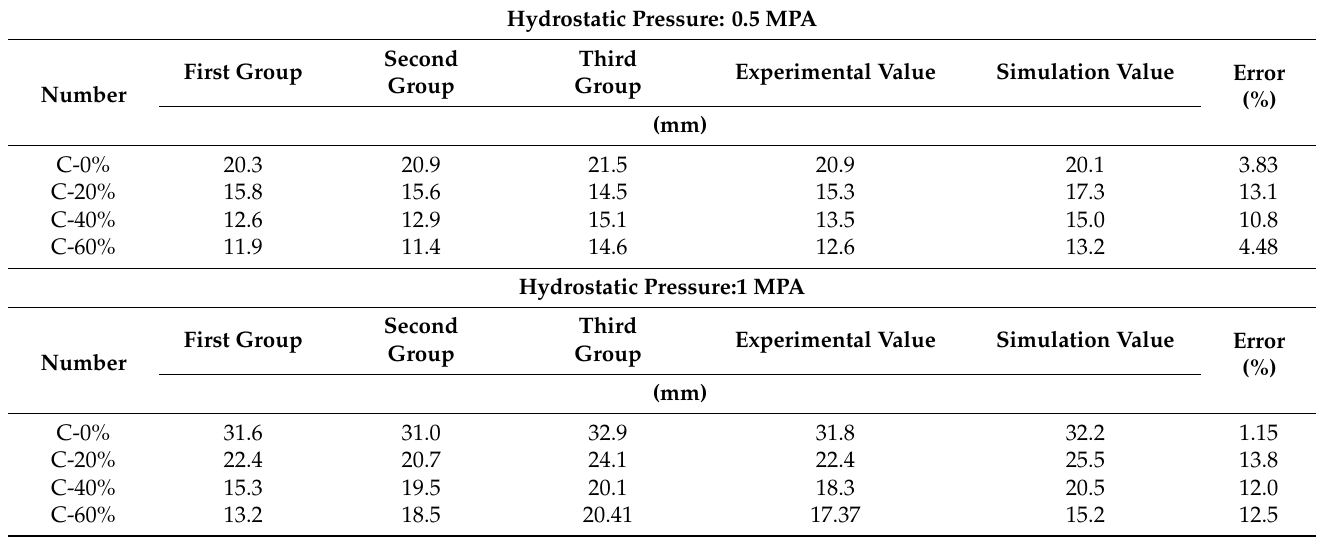
Table 9. Chloride ion penetration test and simulation results of the concrete.